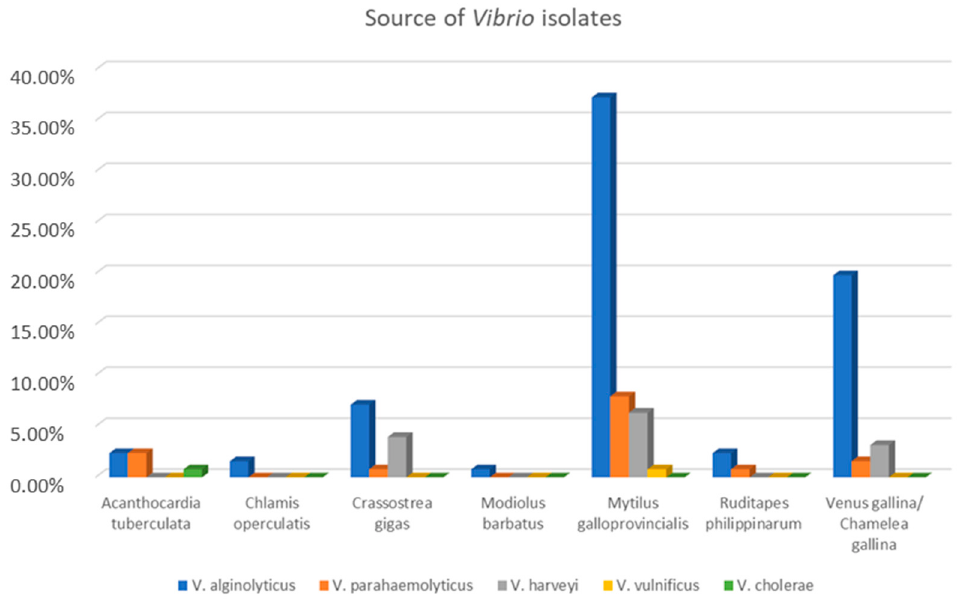
Figure 2 . The percentages of Vibrio species isolated from each shellfish. Figure 2. The percentages of Vibrio species isolated from each shellfish. No pathogenic genes were found in V. cholerae and V. parahaemolyticus isolates, except for one V. parahaemolyticus strain harbouring trh gene. The highest MAR index values